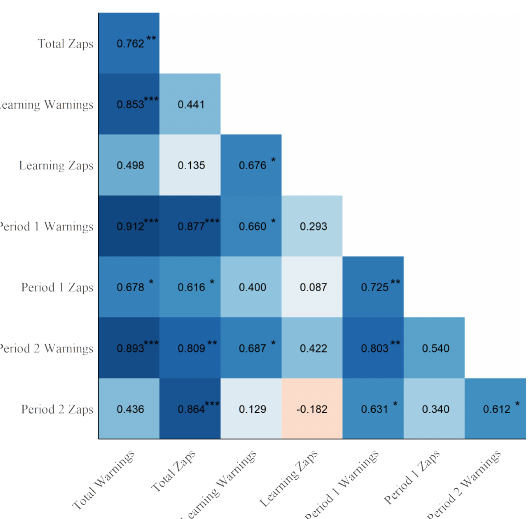
Figure A8. Correlation between auditory warnings and electric pulses received throughout the entire experiment and those received in each of the three periods. The values indicating the Spearman correlation coefficient with the significance level (* p < 0.05; ** p < 0.01; *** p <